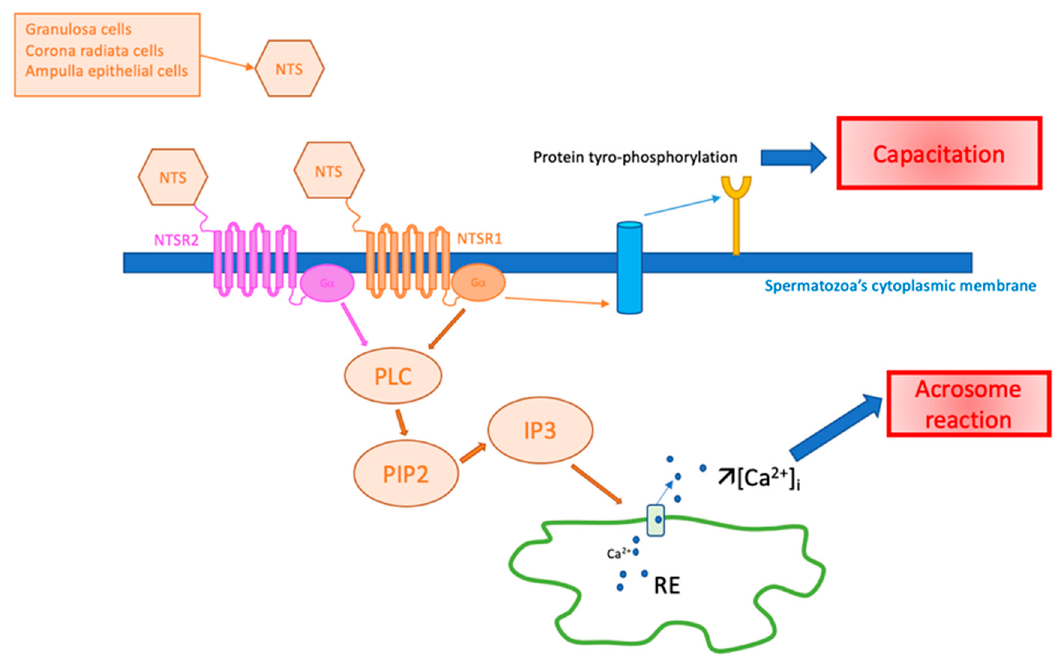
Figure 3. Hypothesis of NTS action on spermatozoa in fertilization. Ca 2+ : calcium ion, [Ca 2+ ] i : intra- cytoplasmic calcium concentration, IP3: inositol triphosphate, NTS: neurotensin, NTSR1: neurotensin receptor 1, NTSR2: neurotensin receptor 2, PIP2: phosphatidyl-inositol 4,5, PLC: phospholipase C, RE: endoplasmic reticulum.